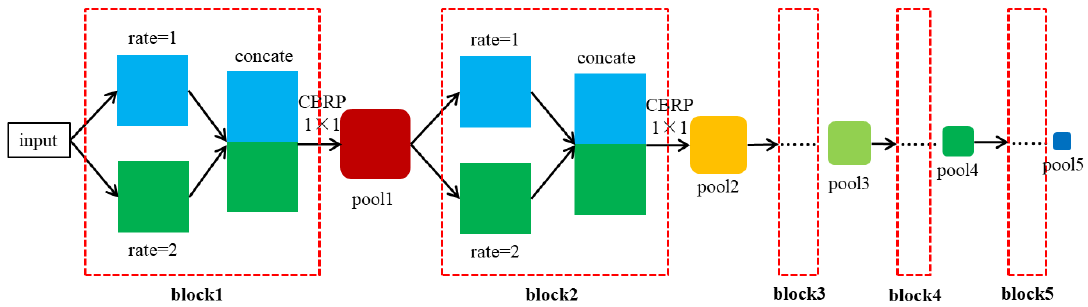
Figure 3. Process of standard and dilated